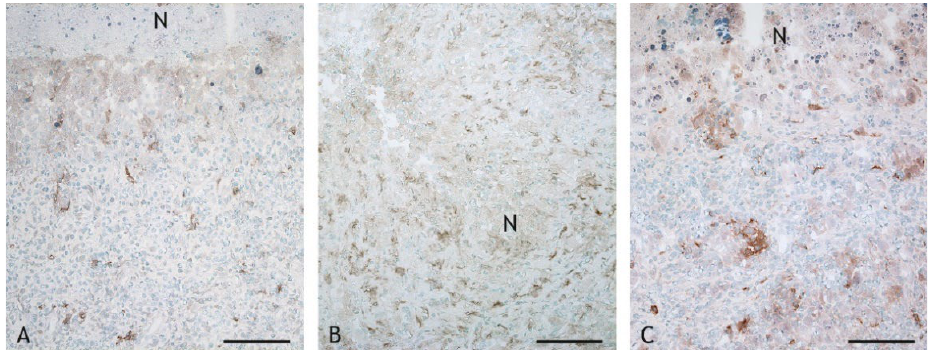
Figure 12. MHC II + DCs adjacent to the central necrosis (N). ( A ). VPM1002-induced granuloma, goat